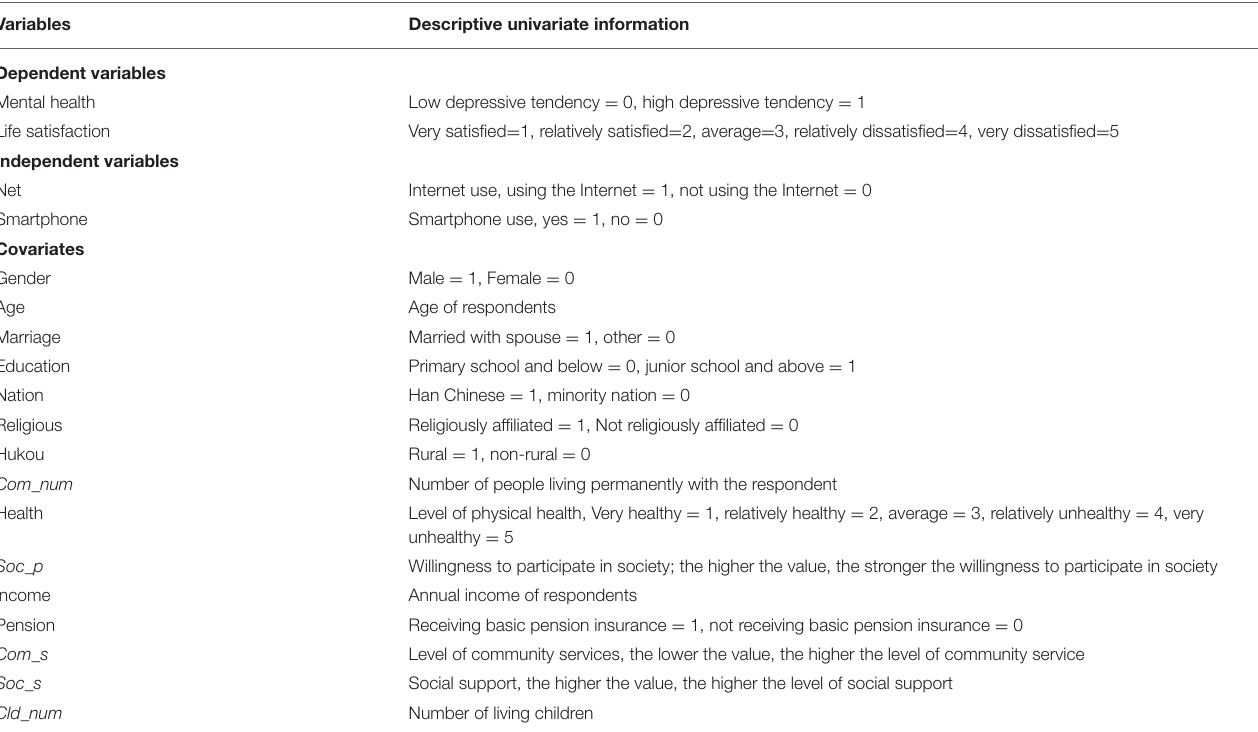
TABLE 1 | Descriptive univariate information for variables. Variables